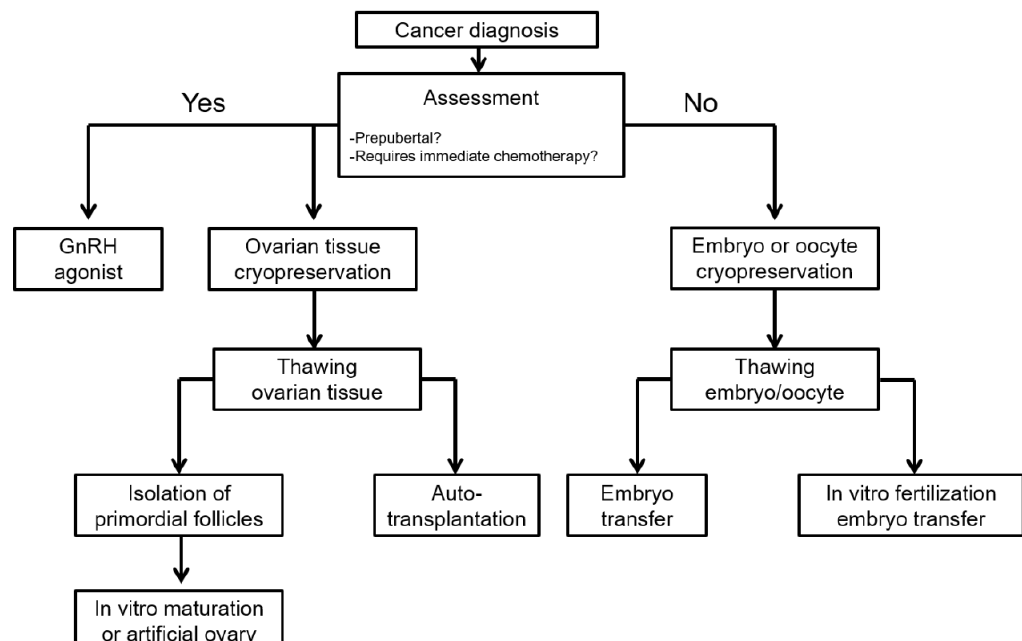
Figure 4. Fertility preservation options for female cancer patients. This could be differentiated by individual situations. Adapted and reprinted, with permission, from Cho, 2020 [45].